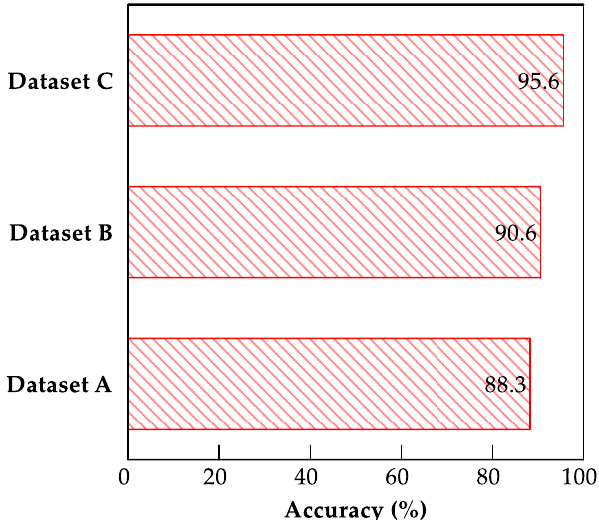
Figure 9. Bar charts showing testing accuracies for datasets A, B, and C using fine-tuned MobileNet CNN model.